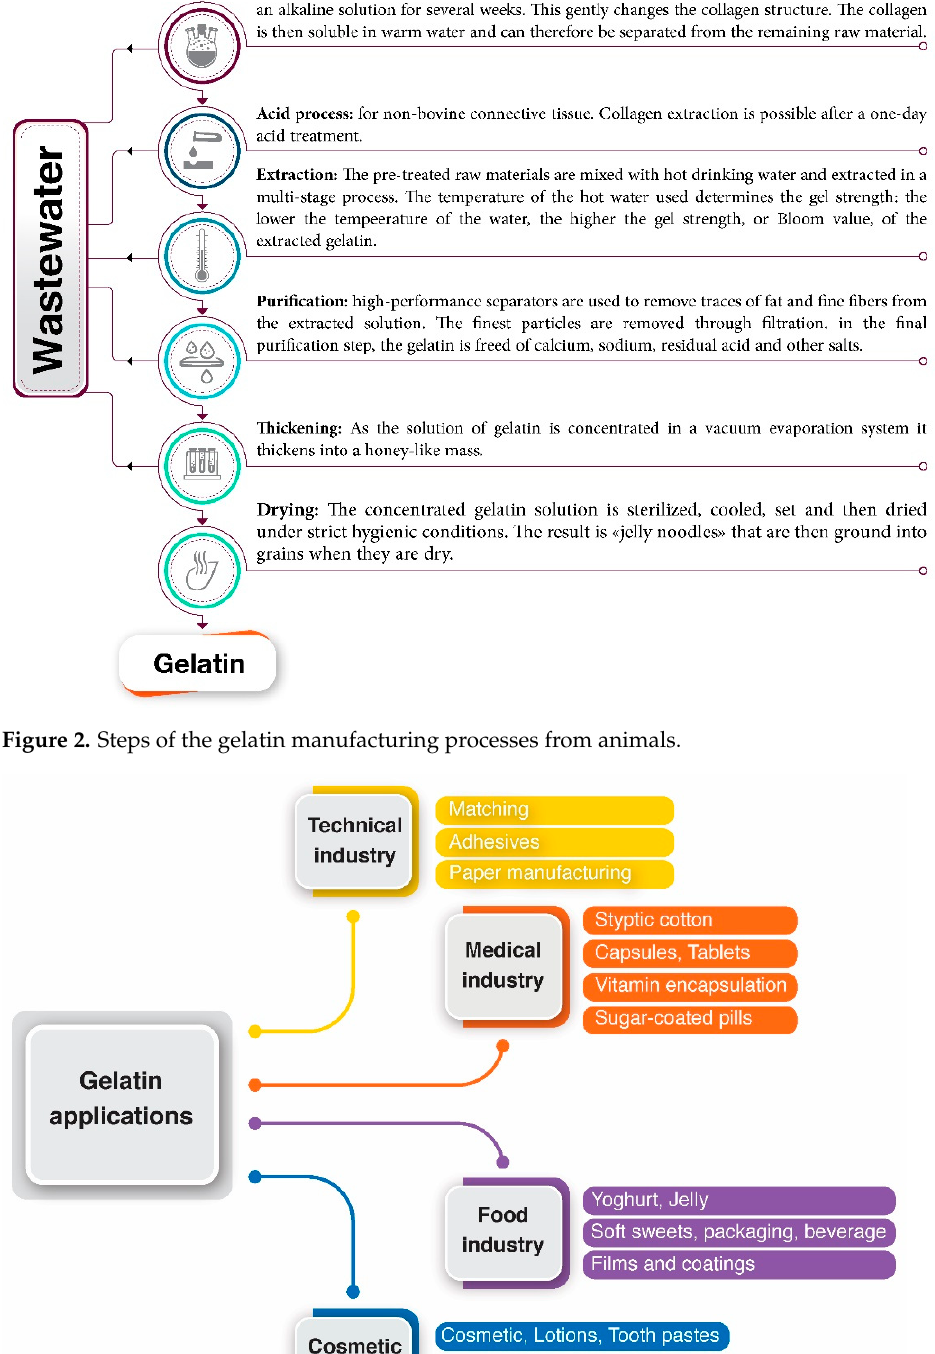
Figure 3. Gelatin applications in the industries.